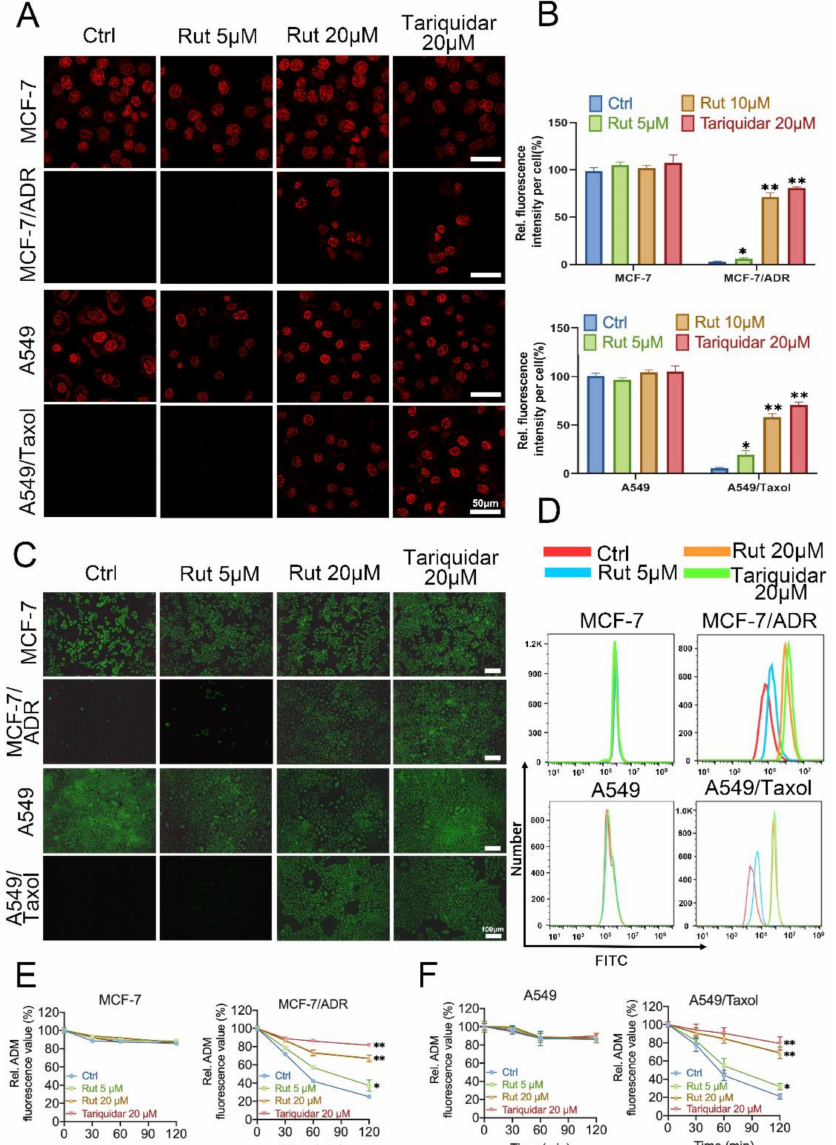
Figure 3. Effects of rutaecarpine on accumulation and efflux in ABCB1-overexpressing cancer cells. ( A ) Cells were observed by laser scanning confocal microscope (LSCM), and the representative images and ( B ) quantitative analysis of adriamycin fluorescence are shown. Adriamycin staining is shown in red. Data are presented as mean SD of three independent experiments. ( C ) Cells were observed ± by fluorescence microscopy, and the representative images of the accumulation of rhodamine 123 are shown. ( D ) Cells were detected by FCM, and the quantitative analysis of rhodamine 123 fluorescence is shown. ( E , F ) The effects of rutaecarpine on efflux of adriamycin in MCF-7, MCF-7/ADR, A549, and A549/Taxol cells. Tariquidar (20 µ M) was used as a positive control inhibitor of ABCB1. Data are represented as mean SD of three independent experiments. * p < 0.05 and ** p < ±